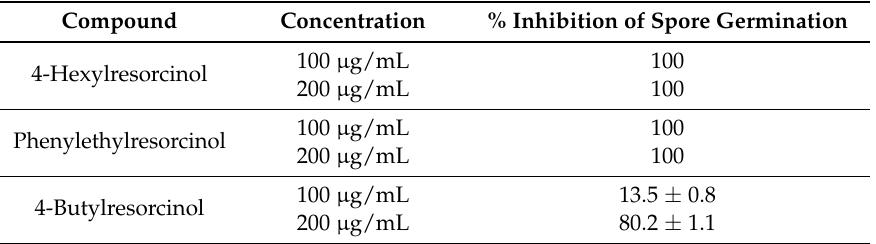
Table 4. Resazurin assay. Percentage inhibition of spore germination after treatment with three resorcinols at doses of 100 and 200 µ g/mL.